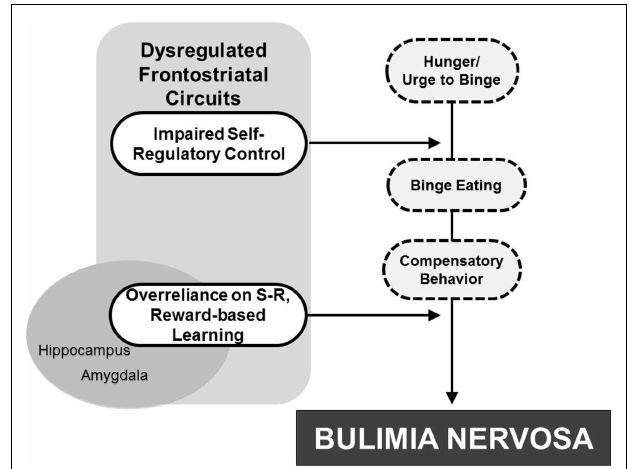
FIGURE 5 | Developmental pathophysiological model of BN .The dysregulation of frontostriatal circuits likely contributes to an impaired capacity for self-regulatory control that interacts with hunger to release eating behavior from regulatory control. Attempts to compensate for weight gain contribute to purging behaviors. Interactions with reward-based learning systems, including striatal and mesolimbic regions, may then allow the binge-eating and purging behaviors to solidify into “habit-like” behaviors, ultimately contributing to BN